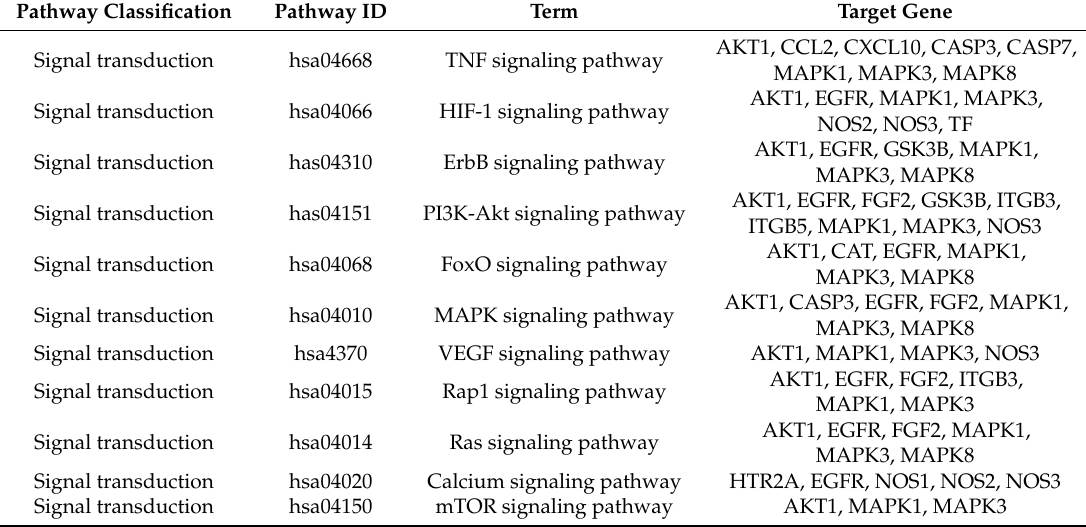
Table 2. Kyoto Encyclopedia of Genes and Genomes (KEGG) pathways and target genes of compounds in Peucedanum japonicum extract (PJE) potentially responsible for the therapeutic activities against